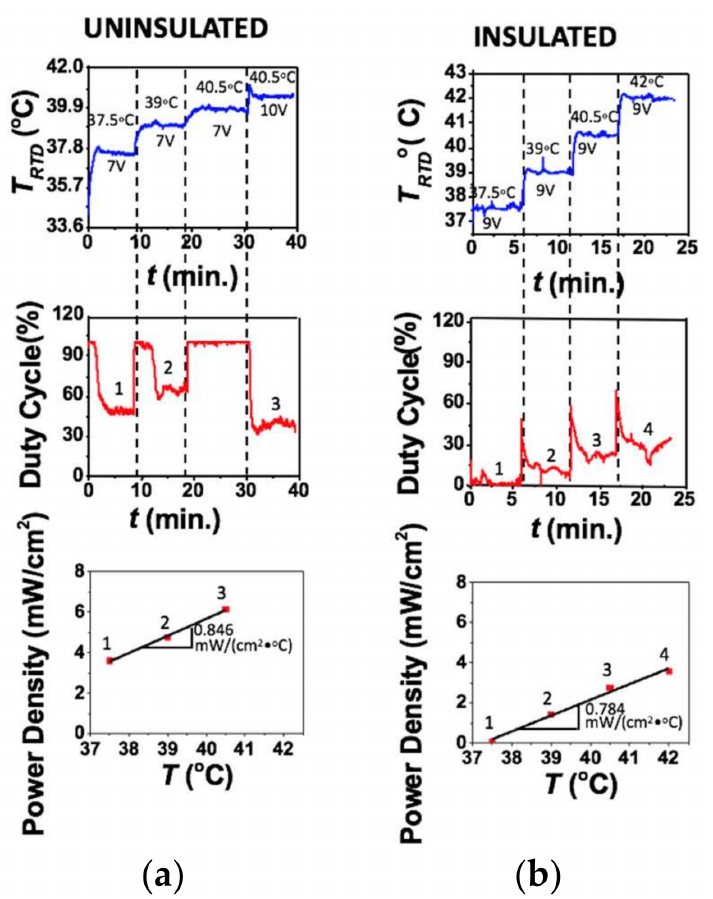
Figure 6. ( a ) Plot of heater temperature versus time as the set points and voltages are changed, followed by a plot of the corresponding duty cycle versus time. The average of the steady state duty cycles marked 1, 2 and 3 were used to calculate the power densities plotted below marked 1, 2 and 3, respectively, at different temperatures; ( b ) The same plots as figure A except the heater is insulated with a piece of